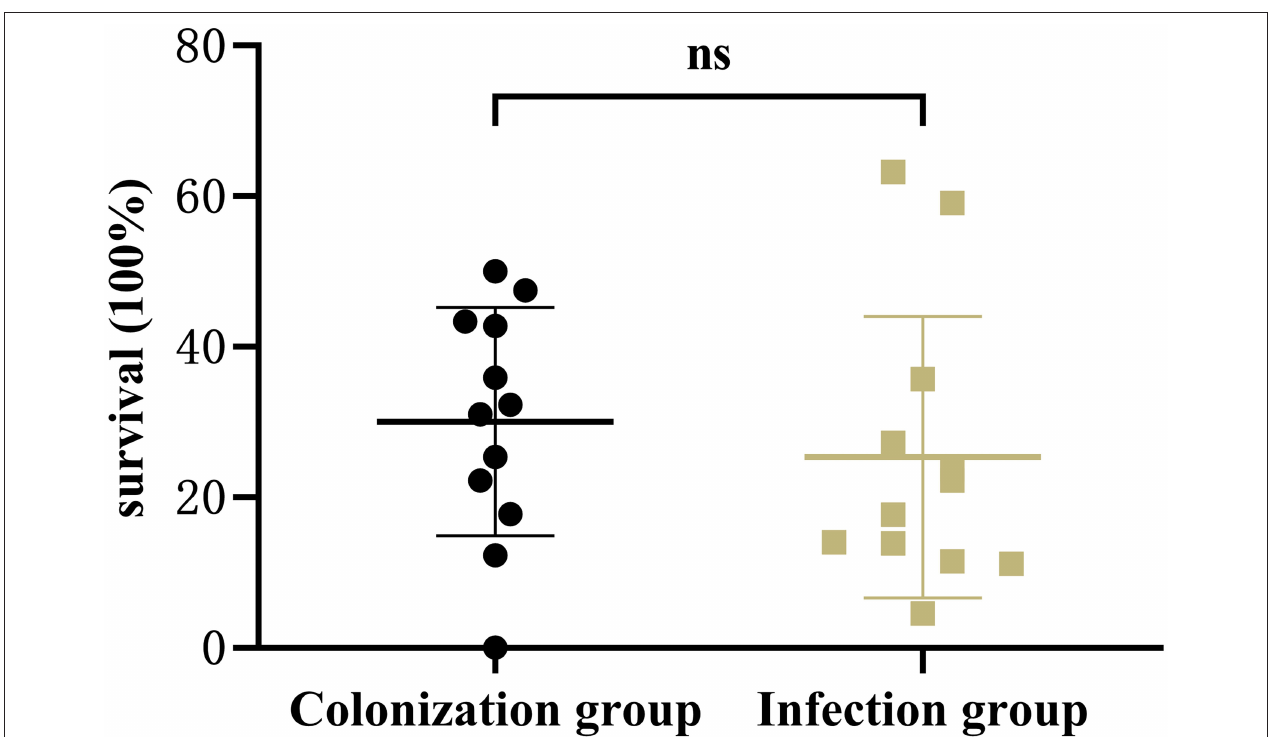
FIGURE 3 | Antiserum ability of intestinal CRKP strains. ns, no significant